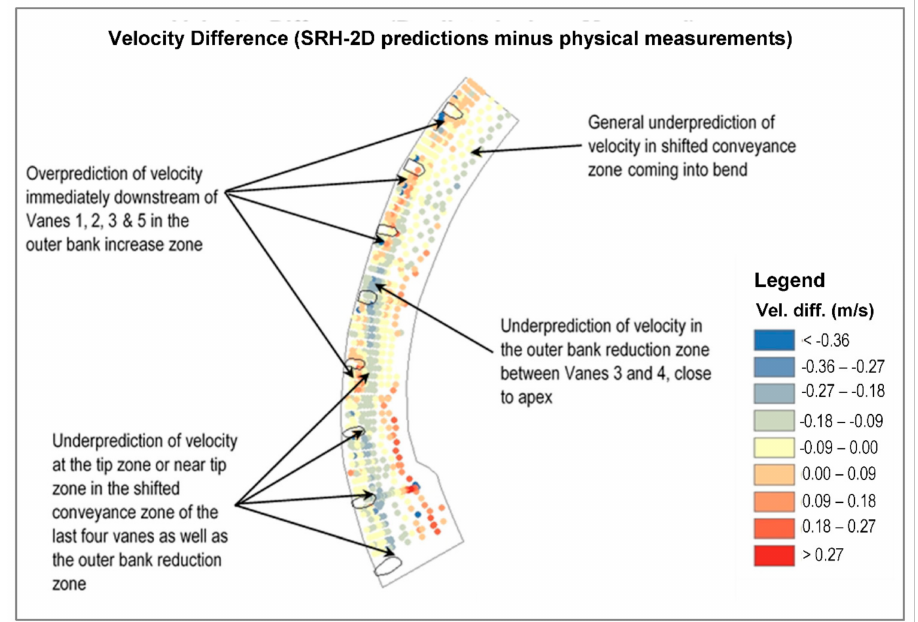
Figure 20. Rock vane configuration V01comparison of point and contour values of depth-average velocity. SRH-2D overpredicts velocities in